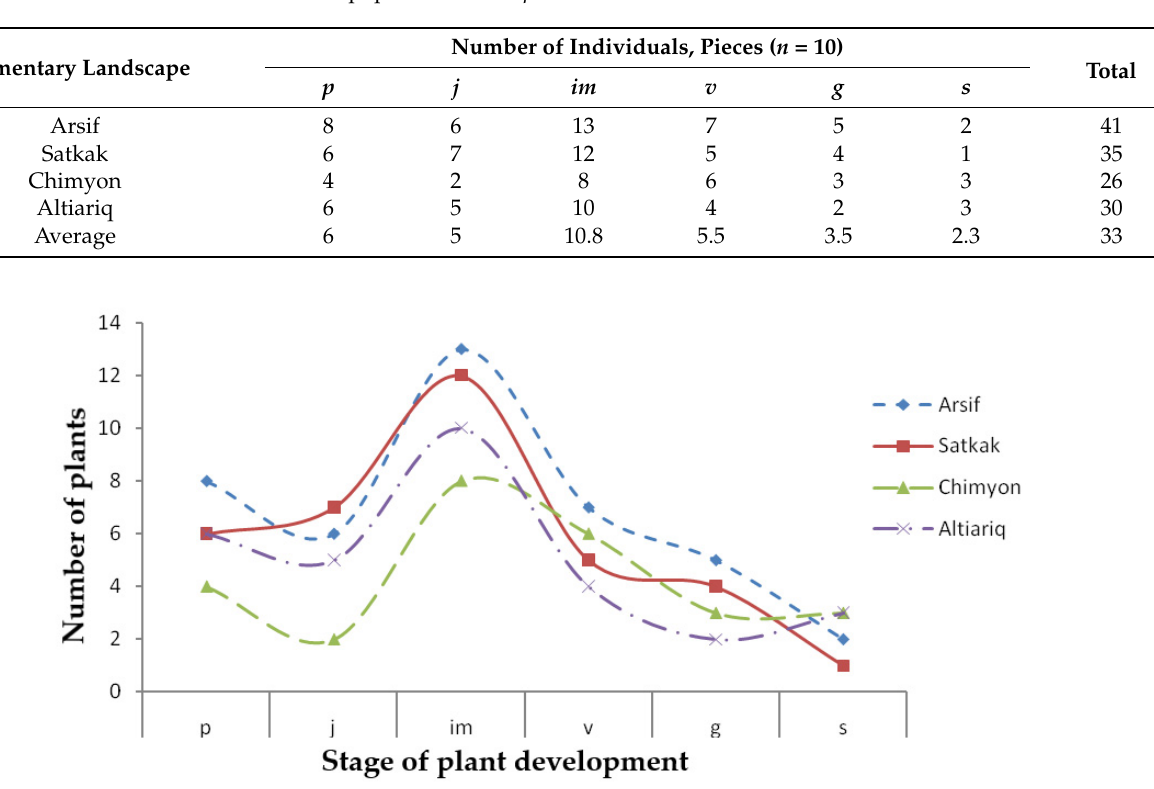
Table 1. Cenopopulation of C. spinosa L.